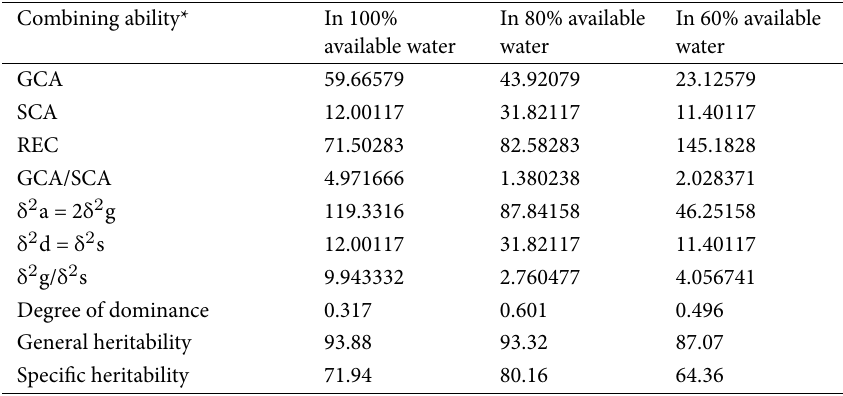
Table 5 Genetic components of tuber yield in genotypes grown under three environmental stress